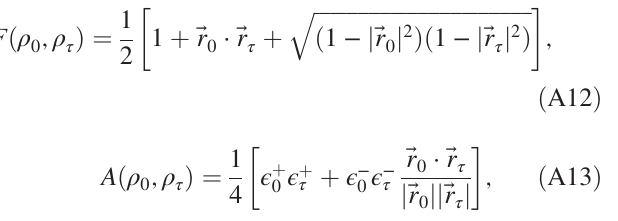
ffiffiffiffiffiffiffiffiffiffiffiffi 1 − r 2